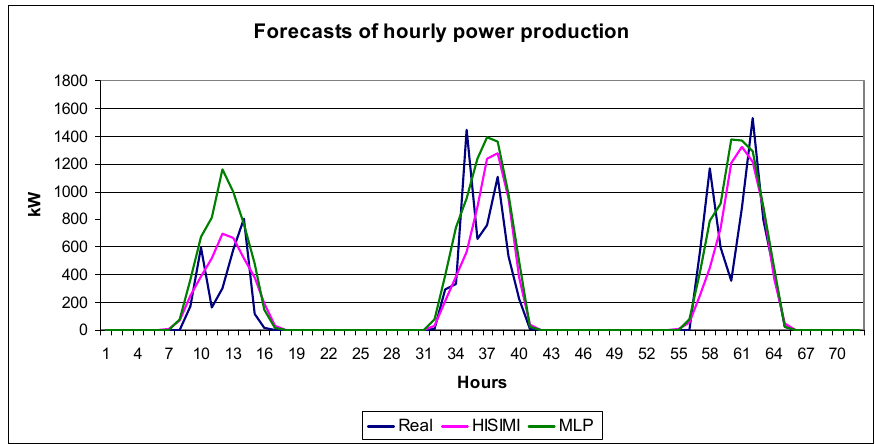
Figure 6. Forecasts of the hourly power production for three cloudy and rainy days in the testing set.